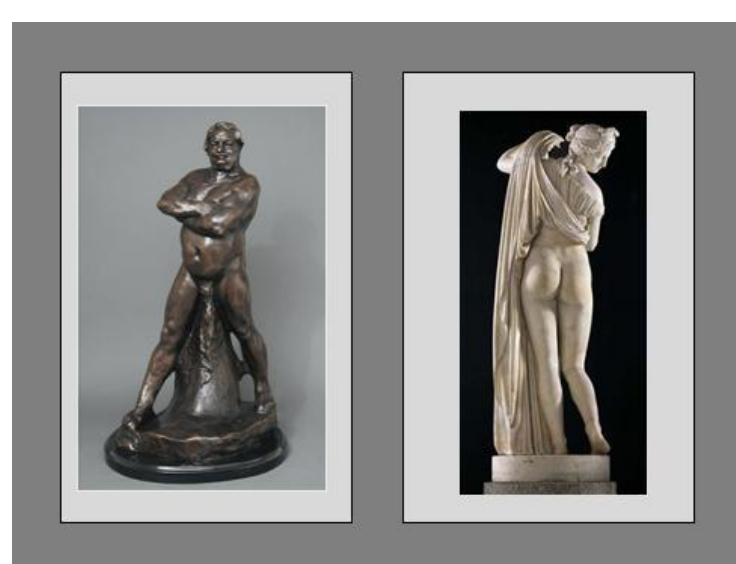
Figure 1. The android- and gynoid-type distribution of adipose tissue depots is the anatomical substrate predisposing to or protecting from metabolic disease. Left-hand side Panel— Balzac Nude Study by Auguste Rodin (1891). Although, in the past, the physiognomy of body fat distribution represented above may possibly have inspired a sense of importance and authority, we now know that it is the typical phenotype associated with MetS and its various complications. Following weight loss, men experience greater reduction in visceral fat and potentially greater improvements in metabolic profile than women, despite similar levels of weight loss [36]. Right-hand side Panel— Callipygian Venus (first or second century BC), a roman copy of an older Greek original (Ἀφροδίτη Καλλίπυγος, i.e., "Aphrodite/Venus of the beautiful buttocks")